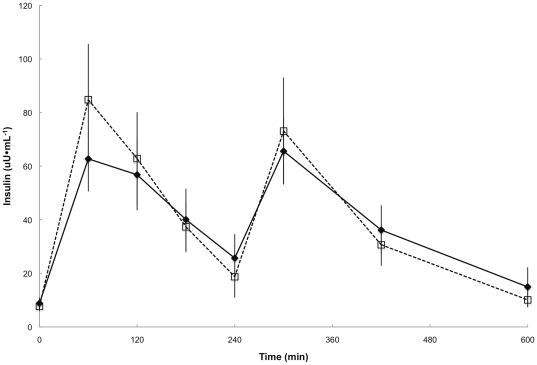
Daytime plasma insulin concentrations.Plasma insulin concentrations during the first 10 h of the experimental meal day. ♦,—represents T(+) men, □, - - -represents T(−) men. There were no significant differences between groups at any time point.